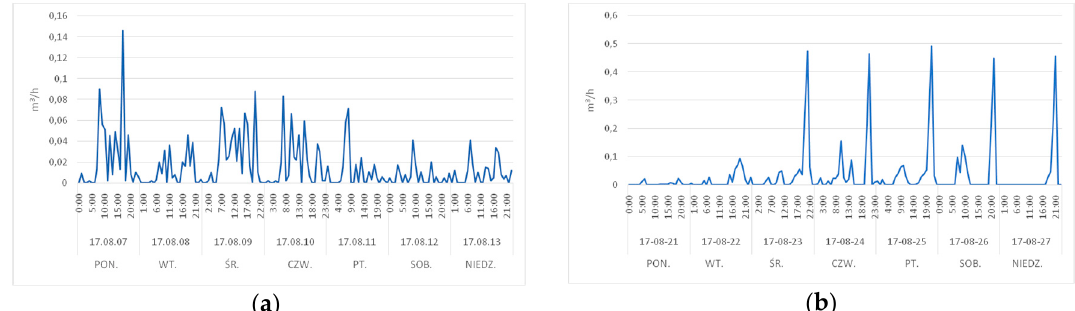
Figure 1. Examples of hourly water consumption in weekly periods in selected single-family houses: